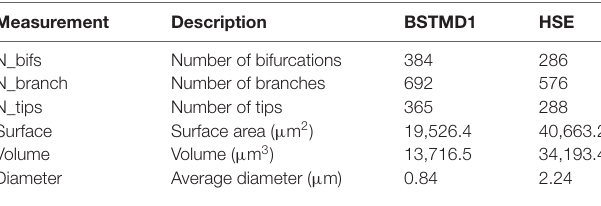
TABLE 1 | A selection of dendritic metrics for each dendritic